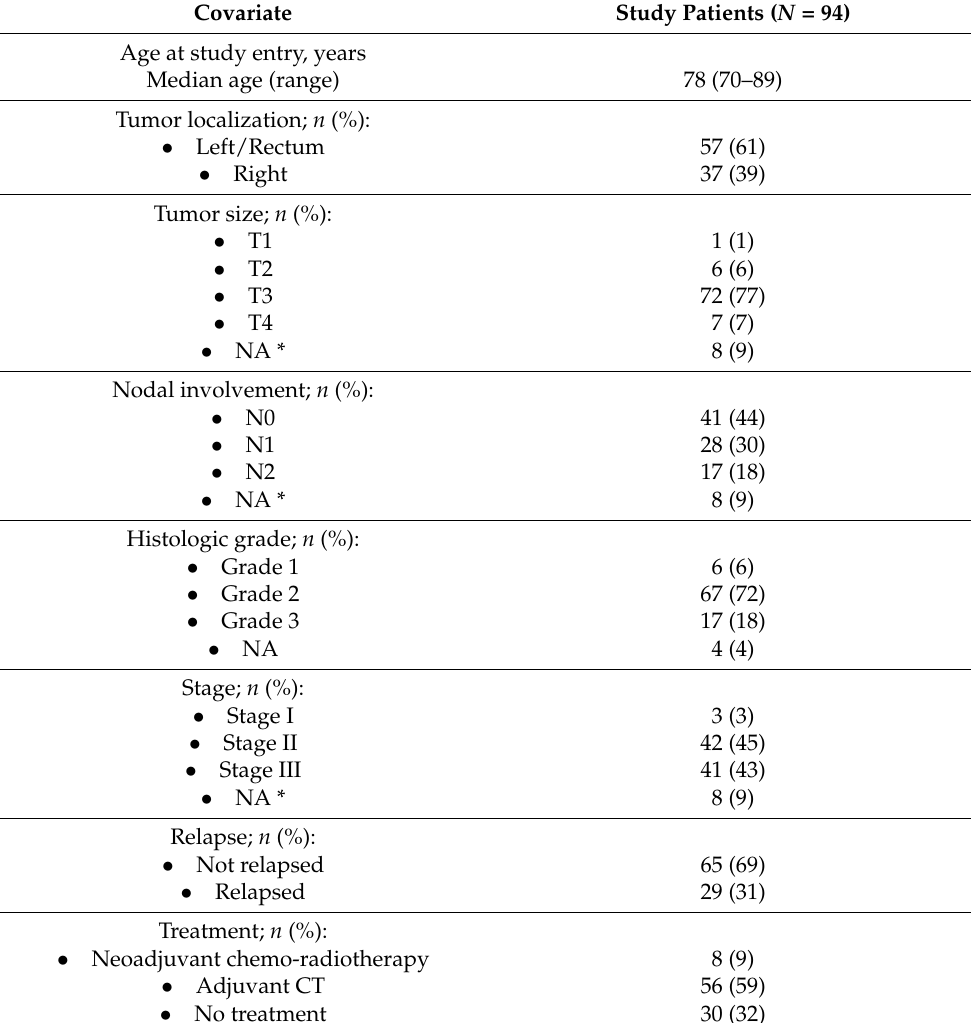
Table 1. Baseline characteristics of the eCRC